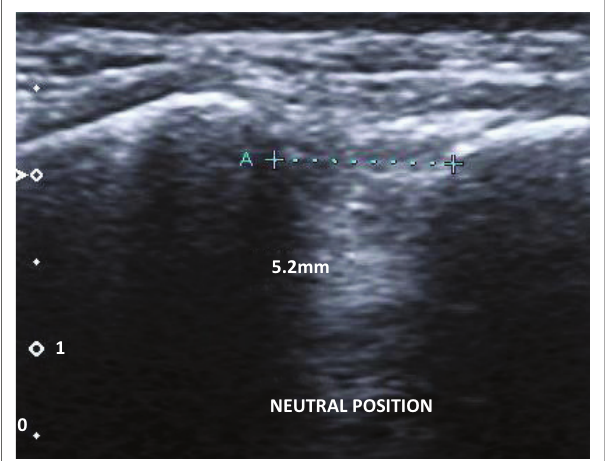
FIGURE 8: Clear space measurement with the foot in forced external rotation (6.2 mm). Widening of the tibiofibular clear space is demonstrated with forced eversion.